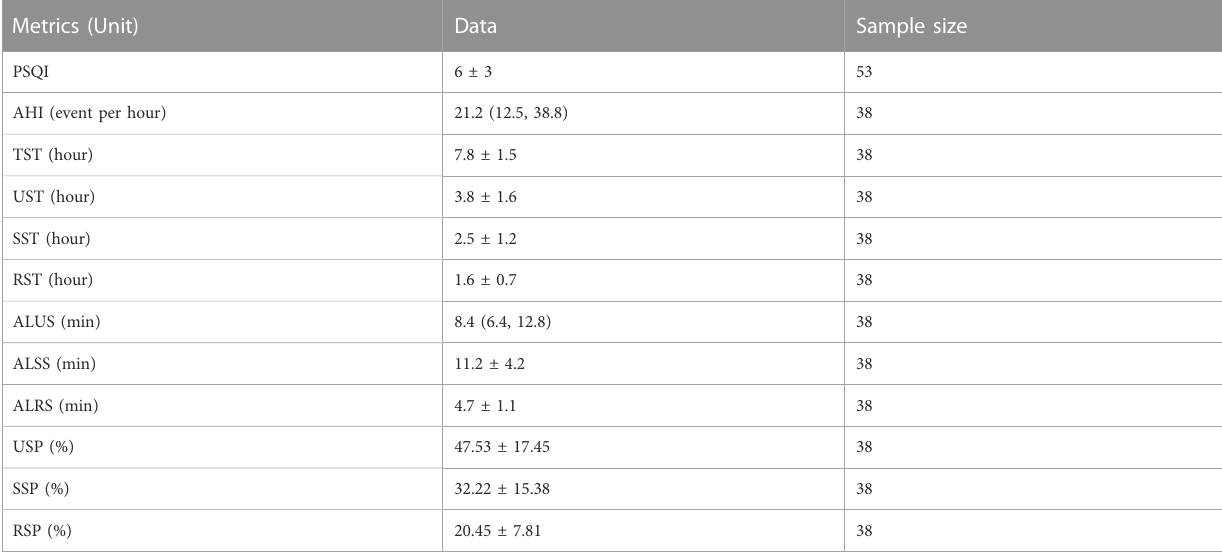
TABLE 2 Sleep quality metrics analyzed in this study. Data are presented as mean ± SD if the variable is normally distributed, otherwise presented as median (p25, p75). Metrics